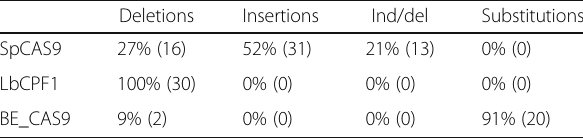
Table 3 Deletions, insertions, deletions plus insertions (Ind/del) and substitutions generated using SpCAS9, LbCPF1 and BE_nCAS9D10A expressed as % of total mutant alleles identified. A total of 60, 30 and 22 mutants alleles were identified for SpCAS9, LbCPF1 and BE_nCAS9D10A respectively (see also Fig.